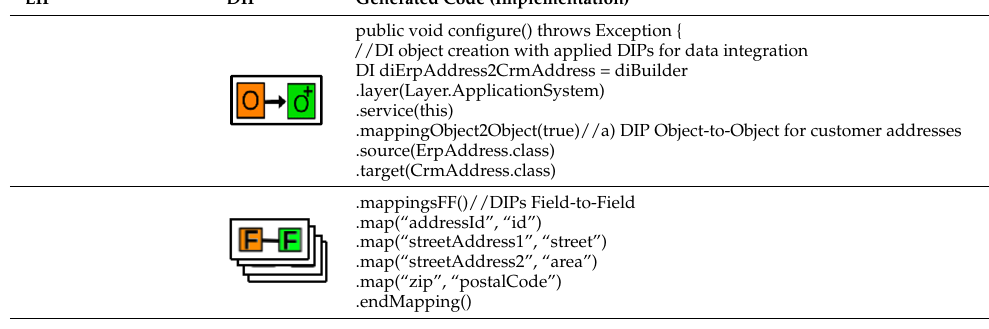
Table 6. Step 9: Application of EIPs and DIPs for the data integration tasks.